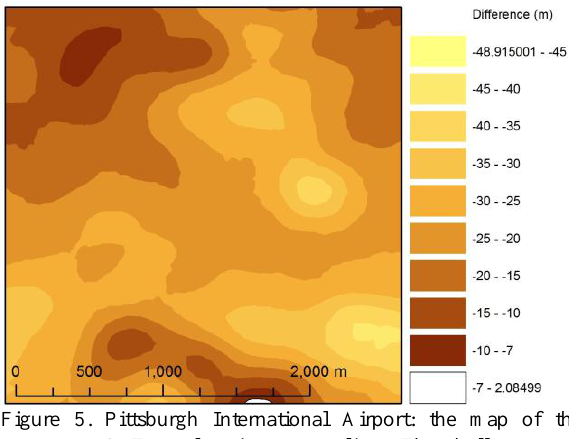
Figure 5. Pittsburgh International Airport: the map of the SRTM elevation anomalies. The hollow areas represent differences in elevation within a range of statistically acceptable disparities.